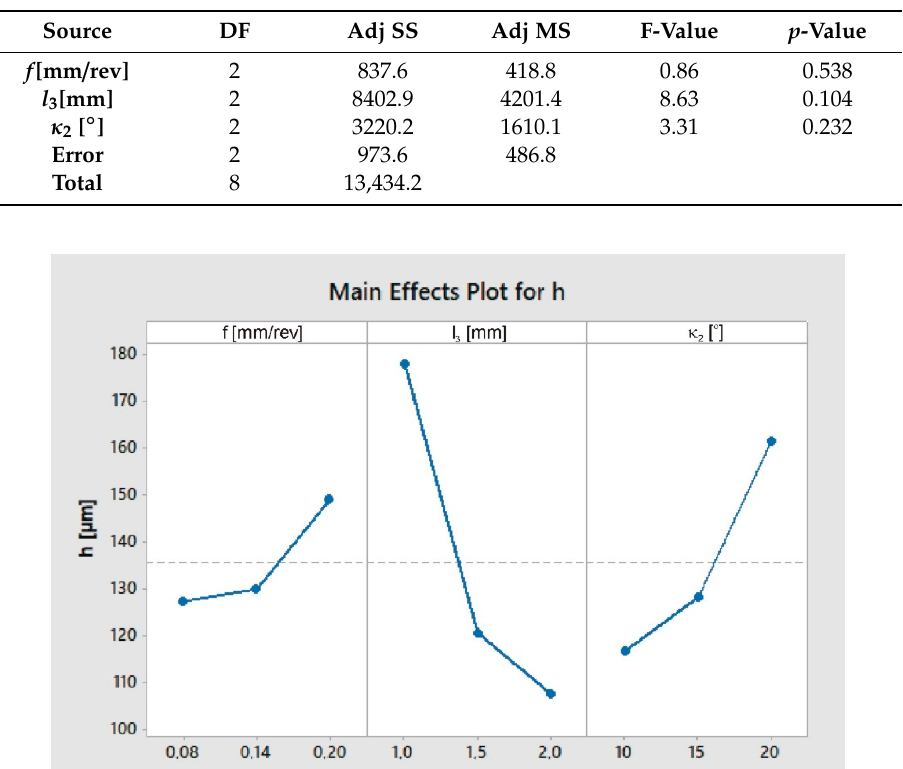
Figure 9. Graphs representing the relation between burr height h and the feed f , chamfer length l 3 and chamfer angle κ 2 .